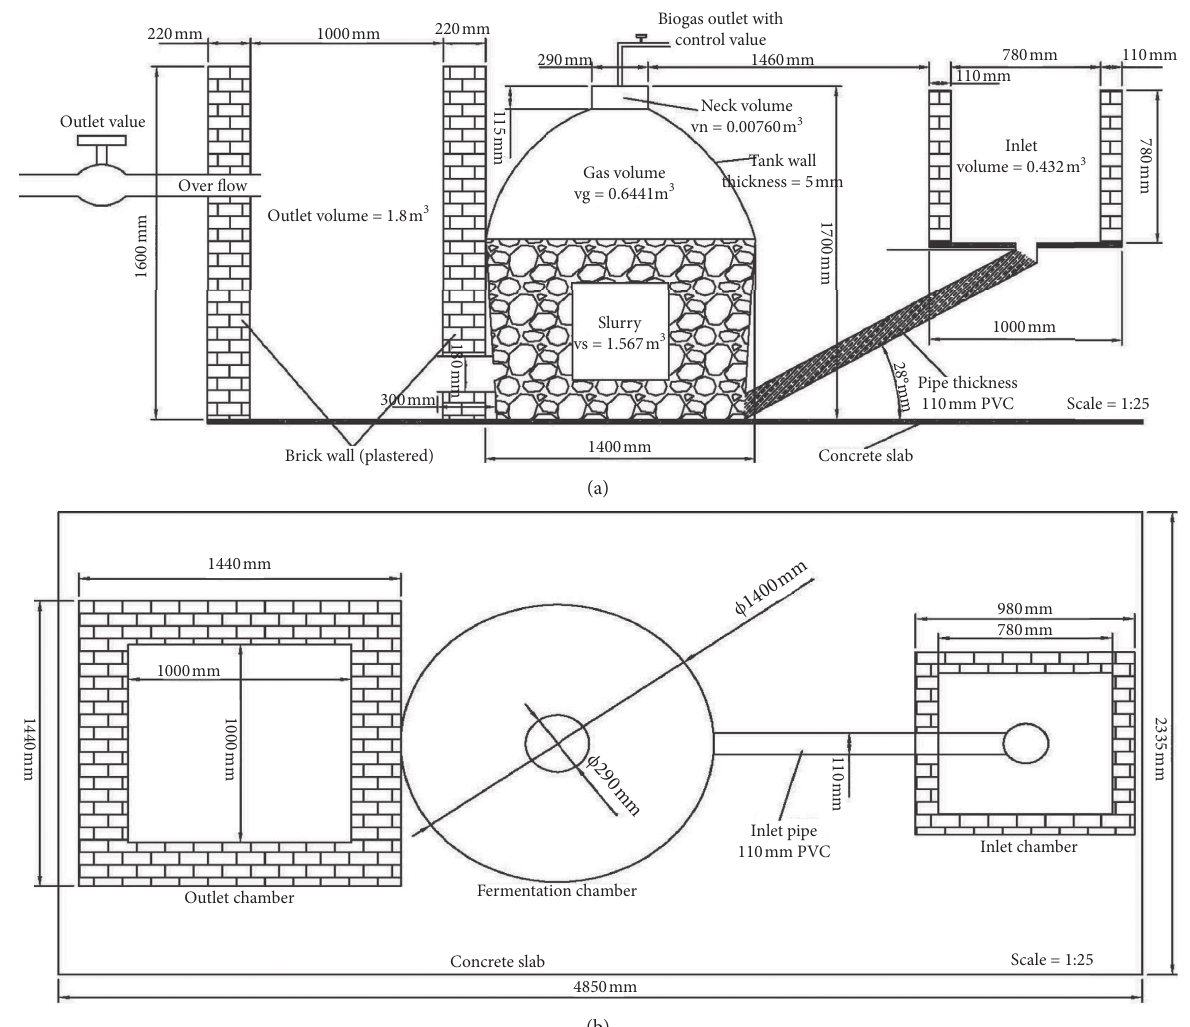
Figure 4: Schematic layout of the designed biogas digester system showing the front and above view. (a) View of the fabricated digester from front. (b) View of the fabricated digester from